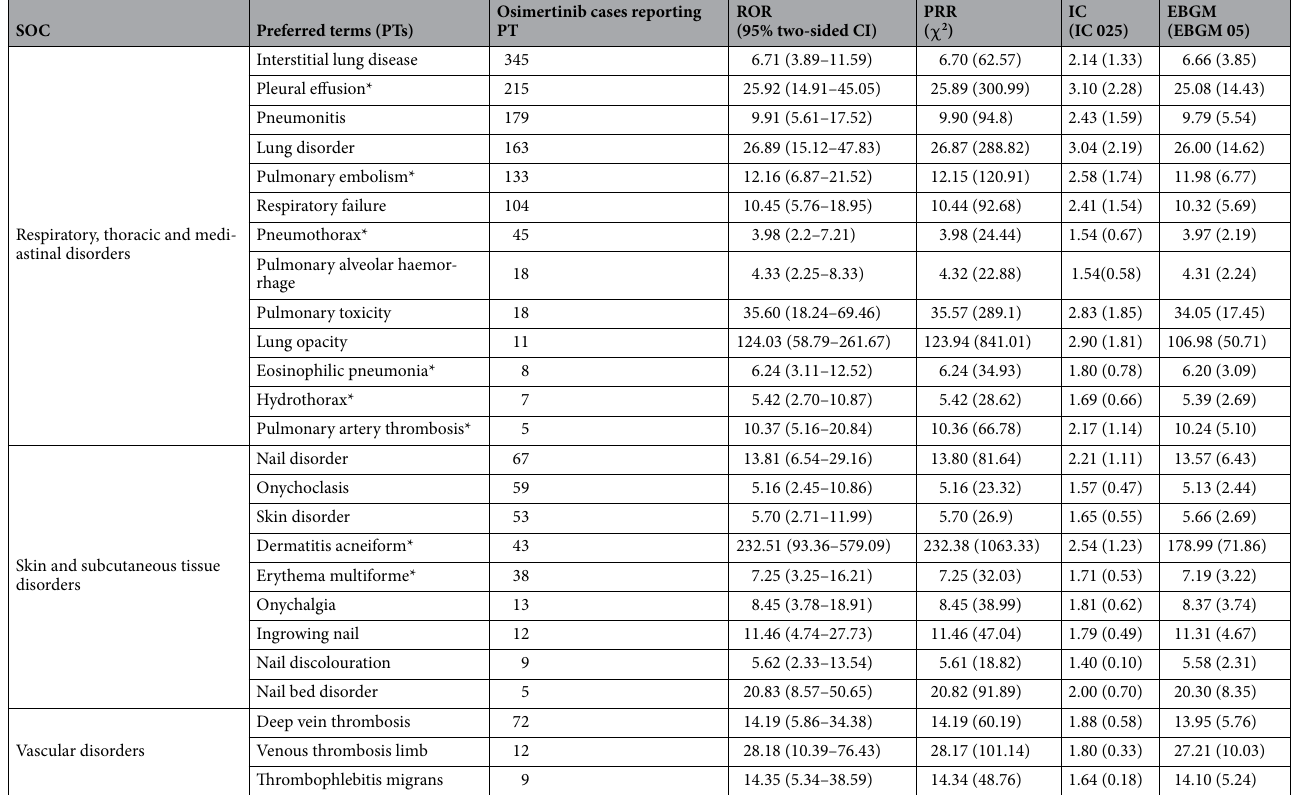
Table 3. Signal strength of reports of Osimertinib at the Preferred Term (PT) level in FAERS database. ROR reporting odds ratio, CI confidence interval, PRR proportional reporting ratio, χ 2 chi-squared, IC information component, IC 025 the lower limit of 95% CI of the IC, EBGM empirical Bayesian geometric mean, EBGM 05 the lower limit of 95% CI of EBGM. *Emerging findings of Osimertinib associated AEs from FAERS